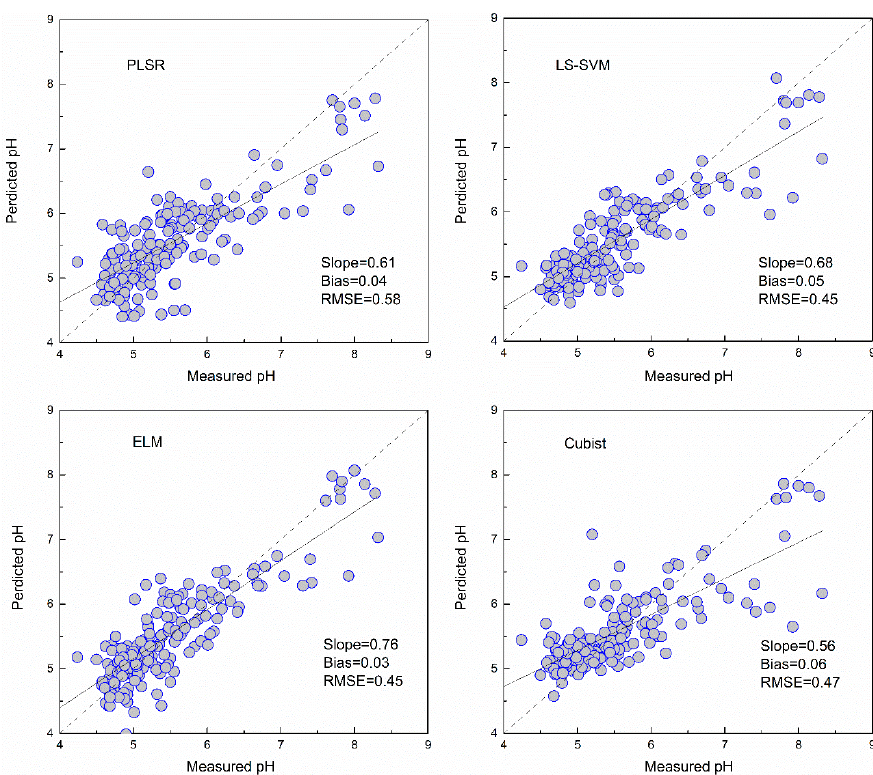
Figure 6. Predicted values against measured values of the validation set for SOM using the PLSR, LS- SVM, ELM and Cubist methods with bands reduced by GA.